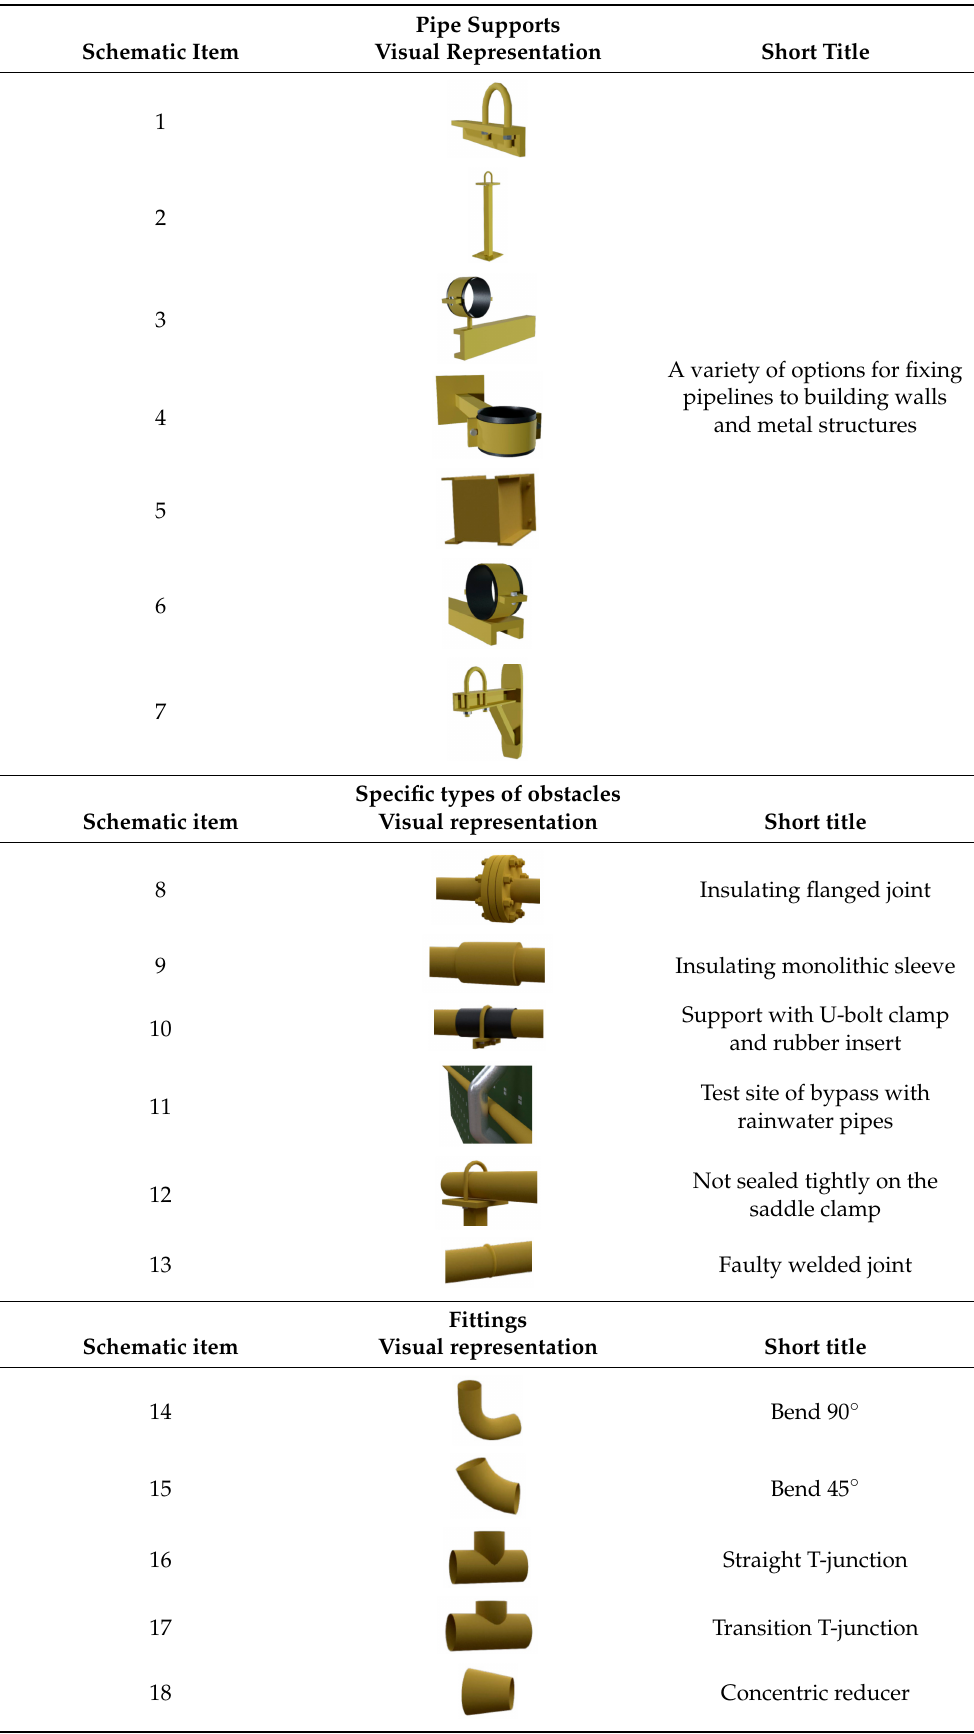
Table 1. Main types of obstacles on the pipeline for robotic